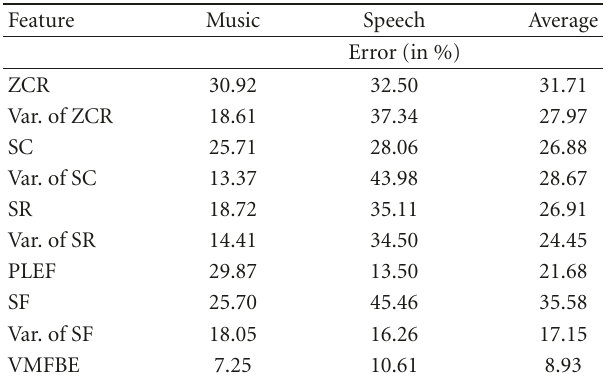
Table 2: Speech/Music discrimination ability of features. Experi- ments were performed on radio broadcast database.